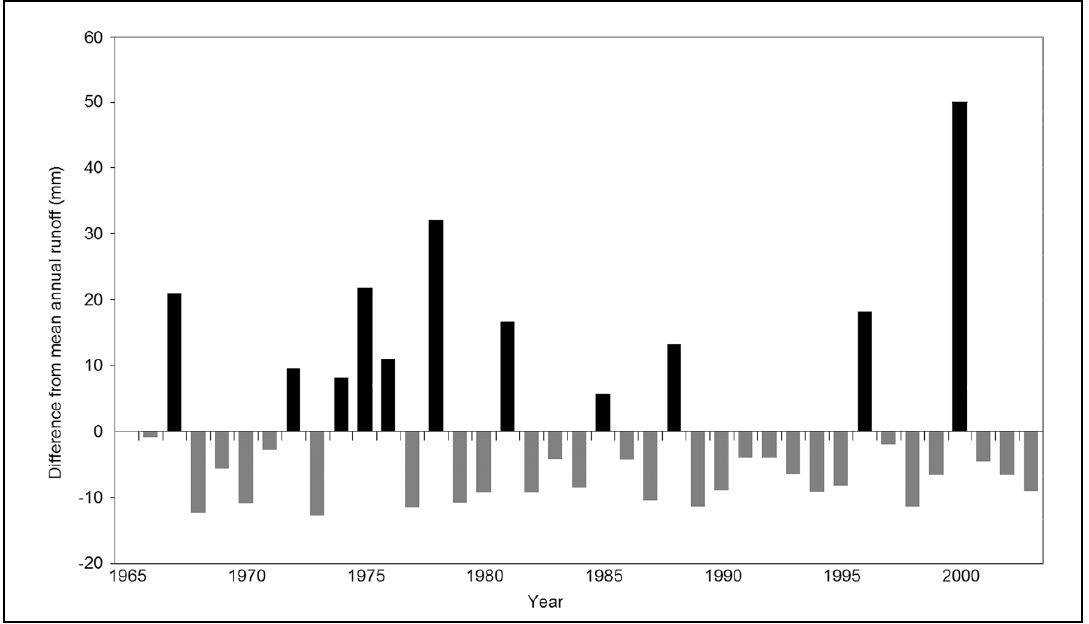
Figure 4. Difference from the mean annual runoff recorded at Combomune, Gaza Province, Mozambique, from 1966 to 2003, showing the irregular hydrological regime of the lower Limpopo River.